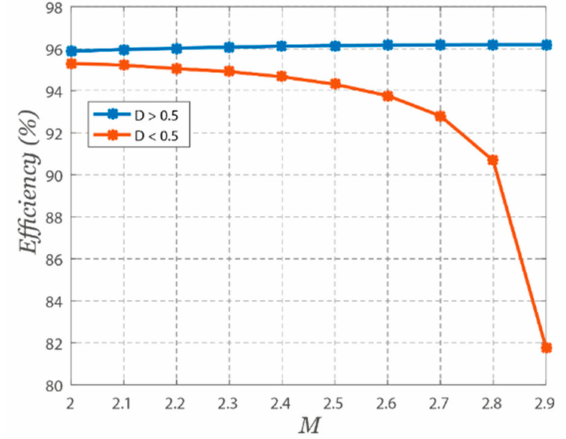
Figure 12. Calculated efficiency curves in the GOA ( V in = 100 V, R L = 120 Ω